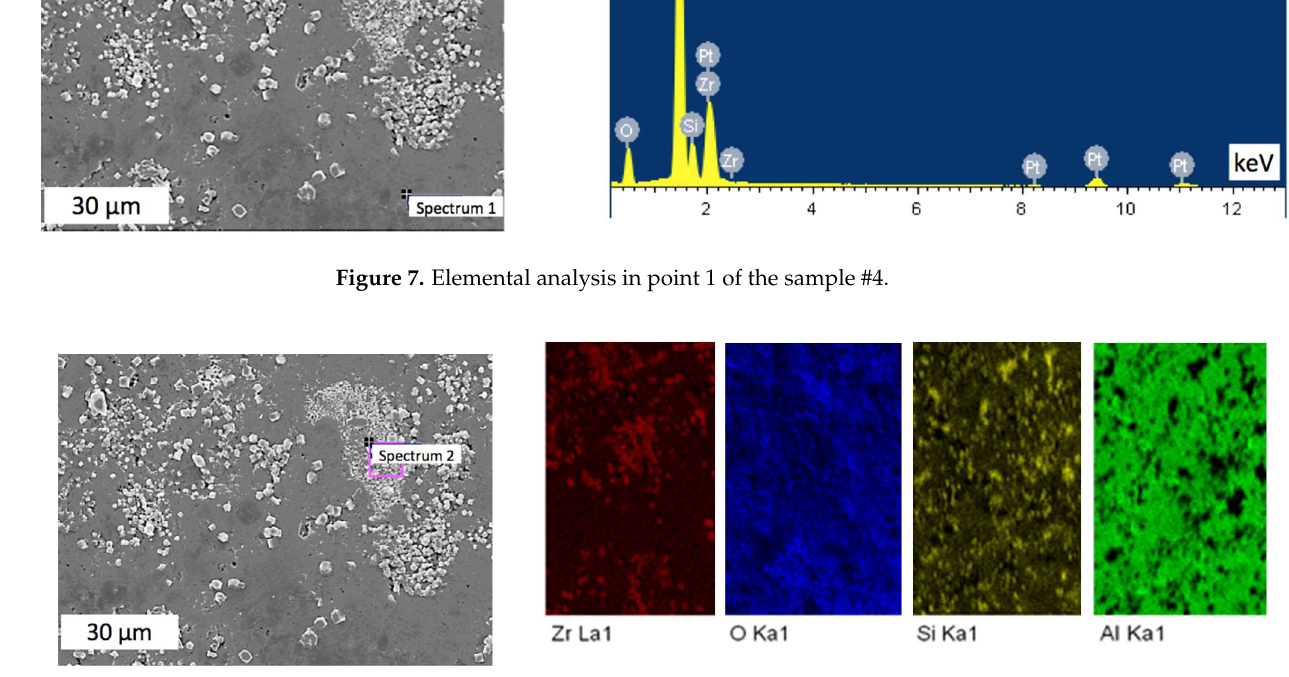
100.00 Figure 10. Elemental analysis in point 4 of the sample #4. Table 4. Elemental proportions in point 4 of the sample #4. Element